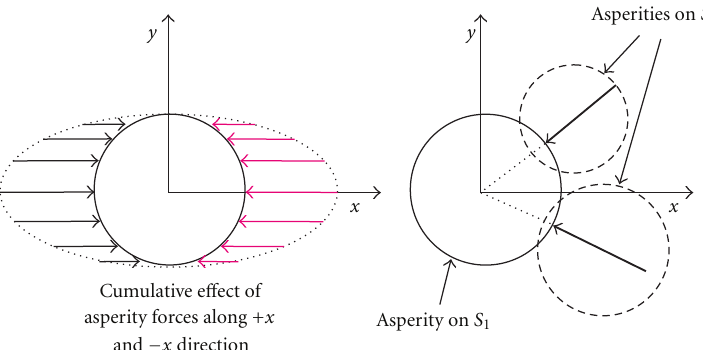
Figure 4: Schematic showing the tangential components of contact force exerted by asperities of S 2 on an asperity on S 1 .